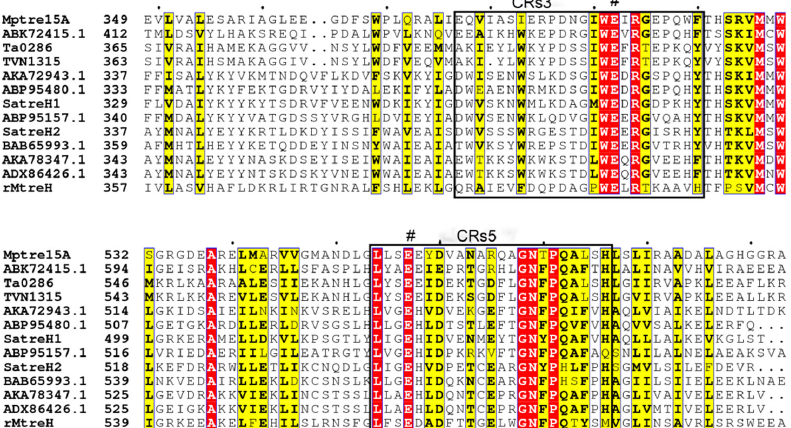
Figure 3. Multiple sequence alignments of M. phyllosphaerae trehalase partial conserved regions with relevant GH15 family trehalases. The sequences aligned are the following: ABK72415.1, Mycobacterium smegmatis MC2 155; LC004405.1, Thermoplasma volcanium TVN1315; LC004406, Thermoplasma acidophilum Ta0286; LC330867, Sulfolobus acidocaldarius SaTreH2; LC330868, Sulfolobus acidocaldarius SaTreH1; ABP95480.1, Metallosphaera sedula DSM 5348; ABP95157.1, Metallosphaera sedula DSM 5348; BAB65993.1, Sulfolobus tokodaii str. 7; AKA78347.1, Saccharolobus solfataricus ; ADX86426.1, Sulfolobus islandicus REY15A; AKA72943.1, Saccharolobus solfataricus ; UHN91757.1, Microvirga sp . MC18 rMtreH. The number sign (#) denotes putative catalytic residues. Fully conserved amino acid residues and related amino acid residues are red and yellow, respectively. Boxes show two highly conserved regions, conserved regions 3 (CRs3) and conserved regions 5